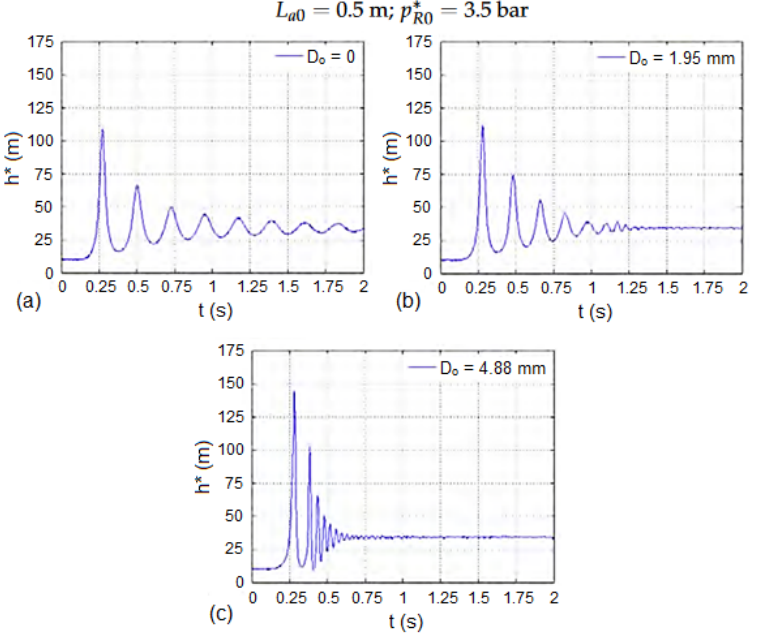
Figure 5. Influence of orifice diameter on system transient behaviour during pipeline filling—the pressure oscillation pattern for the unvented line is compared to two oscillation patterns related to vented lines: ( a ) D o = 0; ( b ) D o = 1.95 mm; ( c ) D o = 4.88